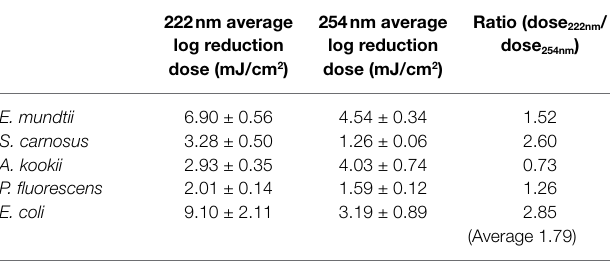
TABLE 1 | Overview of calculated average log reduction doses for various bacteria and